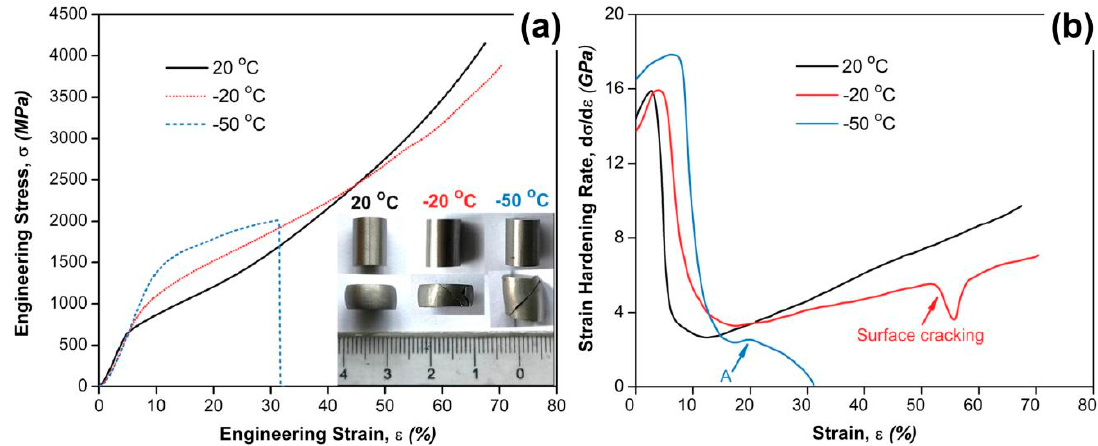
Figure 3. Energy-dispersive X-ray spectrometer (EDS) surface mapping showing the composition distribution of Fe-Ni-P alloys before/after cryogenic treatment: ( a ) 20 °C; ( b ) −20 °C; ( c ) −50 °C.